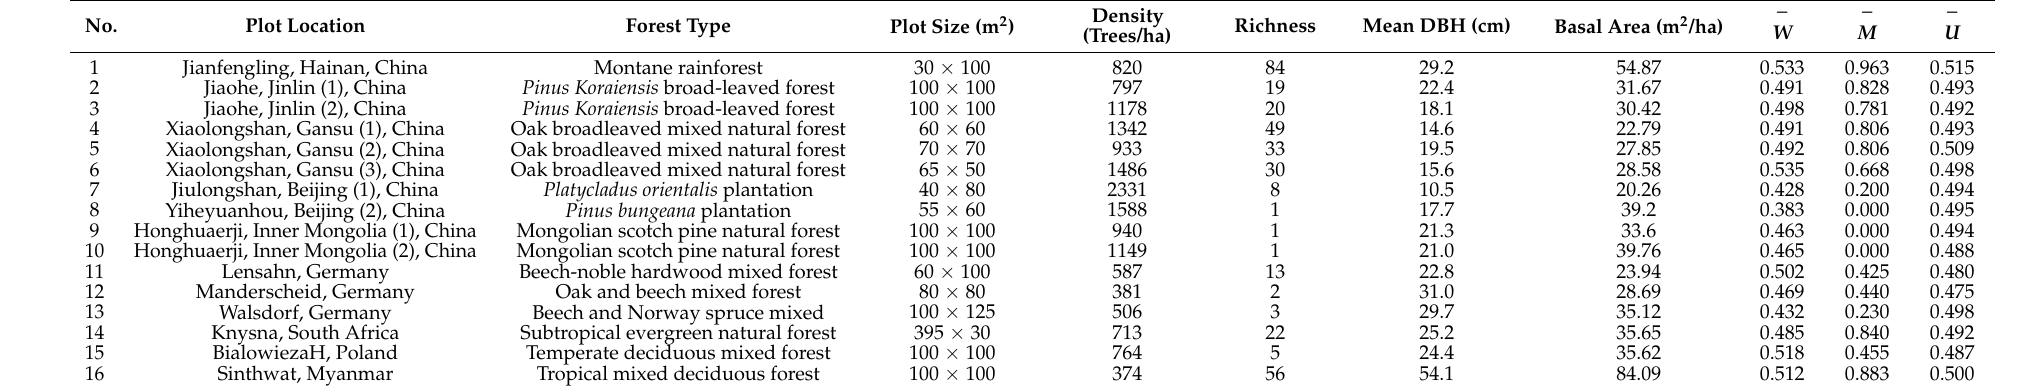
Table 3. Basic characteristics of the plots used in this